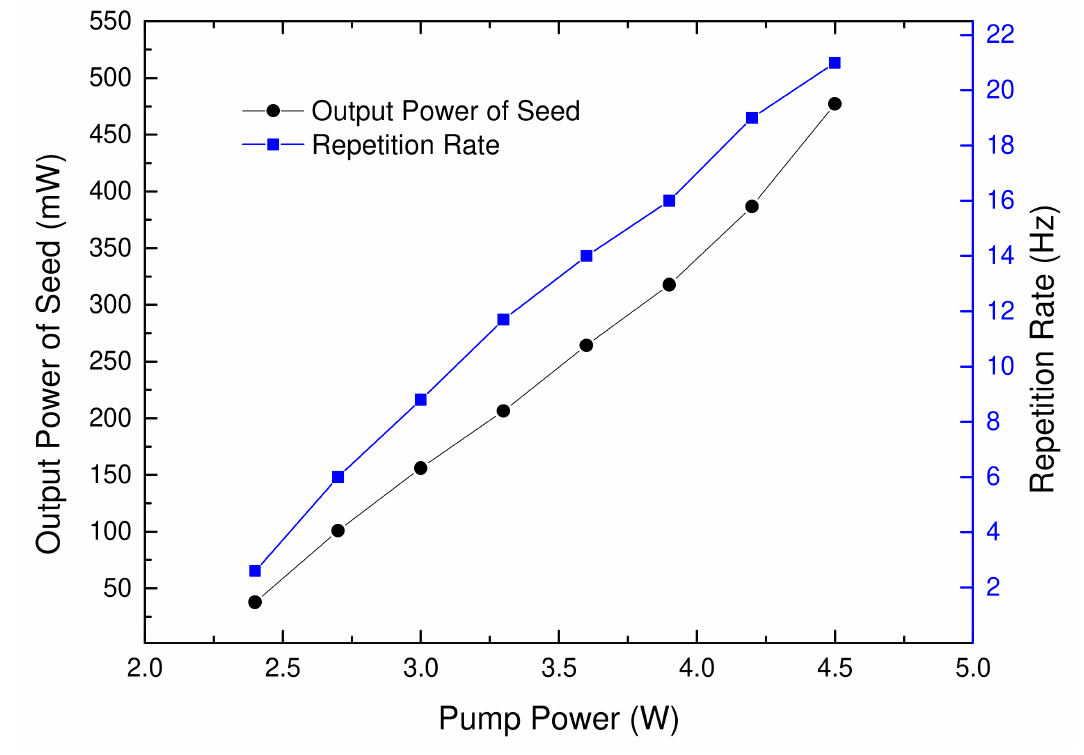
Figure 2. The average power and repetition rate of the seed versus pump